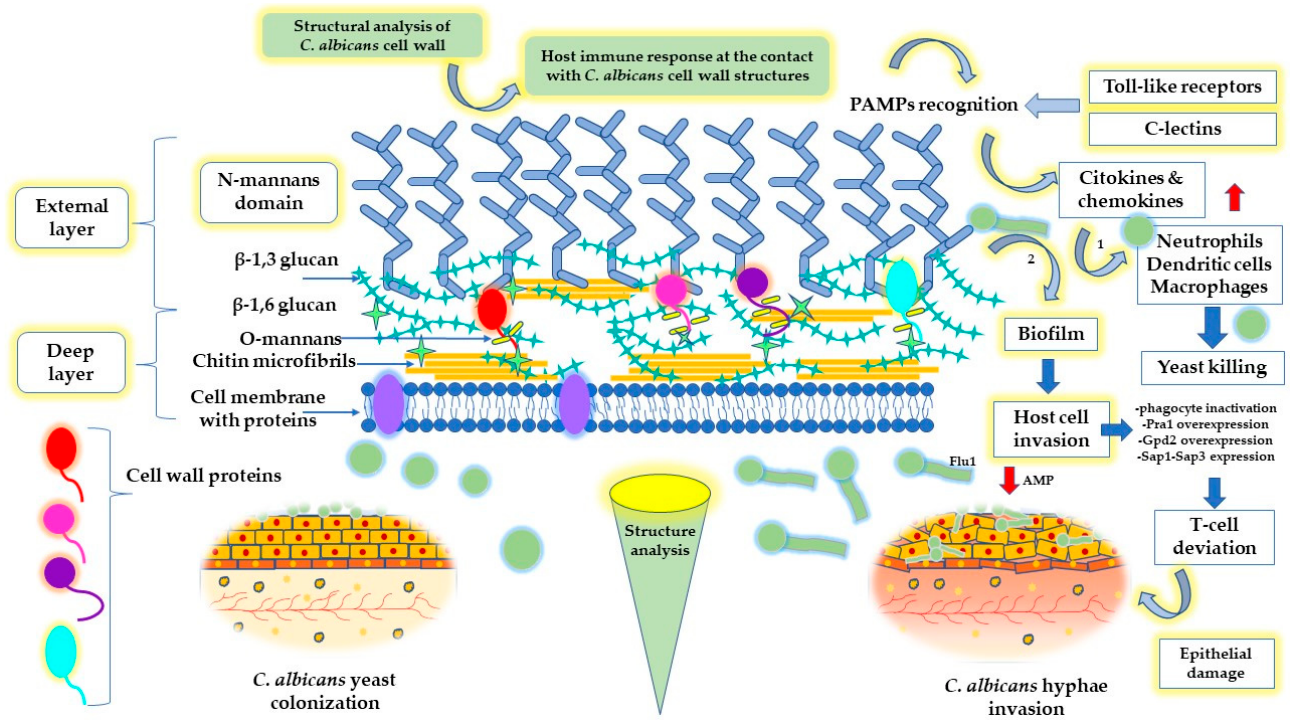
Figure 2. Cell wall structure and host immune defense in C. albicans epithelial infection.